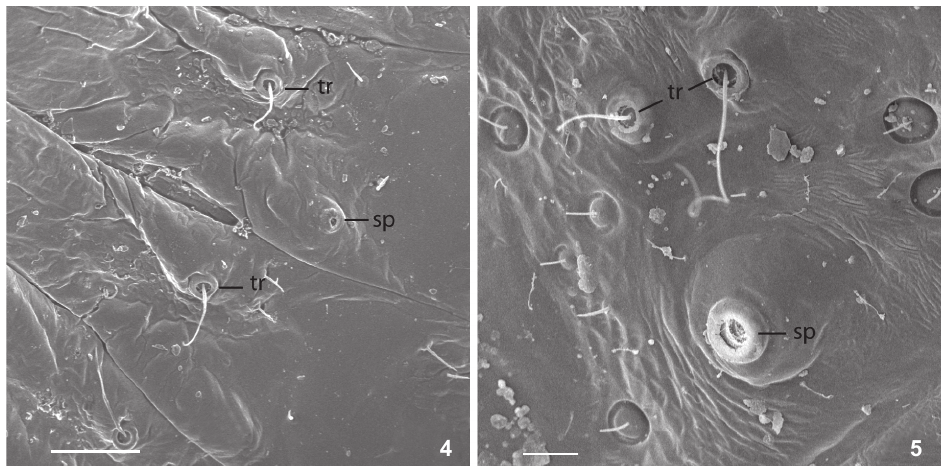
µm.Figures 4-5. Lateral margin of abdominal segments of Euschistus (Mitripus) grandis under scanning electron microscopy: (4) first instar, segments IV-V; (5) second instar, segment V. (sp) spiracle, (tr) trichobothrium. Scale bars: 4 = 50 µm, 5 = 20